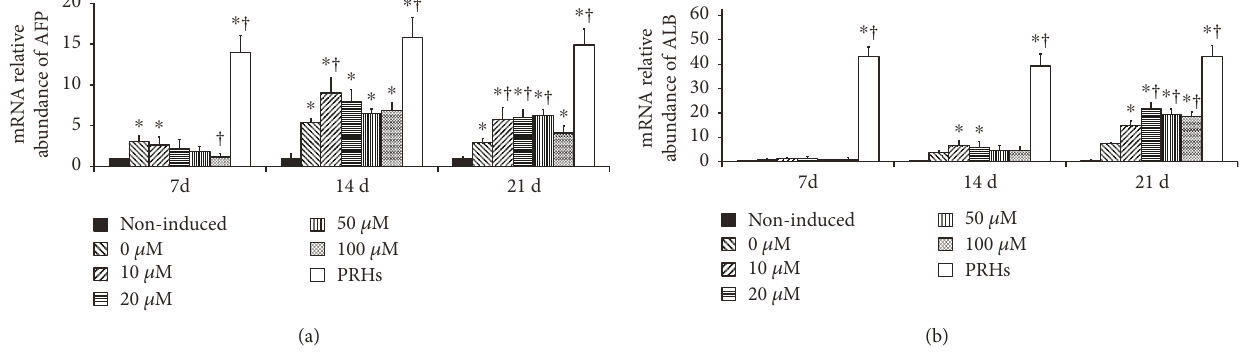
Figure 2: Zebularine promoted the mRNA expression of AFP and ALB. Noninduced BMMSCs and primary rabbit hepatocytes (PRHs) were used as negative or positive controls. (a) On day 7, noninduced BMMSCs expressed little AFP; increased AFP mRNA expression was observed in 0 and 10 μ M groups. On day 14, zebularine exhibited signi fi cant e ff ect on AFP expression, with the highest expression level in 10 and 20 μ M groups. (b) Noninduced BMMSCs expressed little ALB. The mRNA levels of ALB started to increase at 14 days after pretreatment of zebularine at concentrations of 10 and 20 μ M. Exposure to zebularine exhibited signi fi cant e ff ect on ALB expression after 21 days, with the highest expression level in the 20 μ M group. Asterisk indicates p < 0 05 compared with the control group; dagger indicates p < 0 05 compared with the 0 μ M (HGF) group.